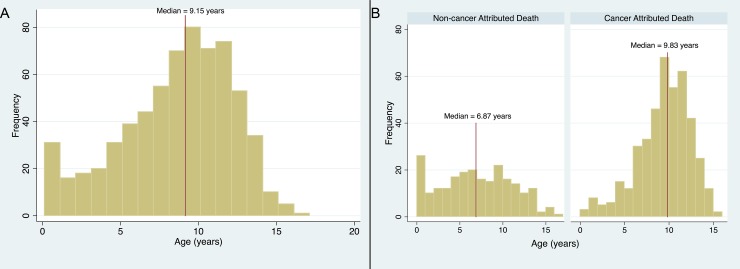
Age distribution of golden retriever dogs.(A) Histogram of age for all golden retriever dogs undergoing a necropsy exam with a median age of 9.15 years. (B) Histogram of ages of all golden retriever dogs undergoing a necropsy exam categorized by having a death attributable to cancer or not with a median age of death for those dogs dying of non-cancerous cause of 6.87 years and a median age of death of 9.83 years for those dogs with a cancer attributable death.